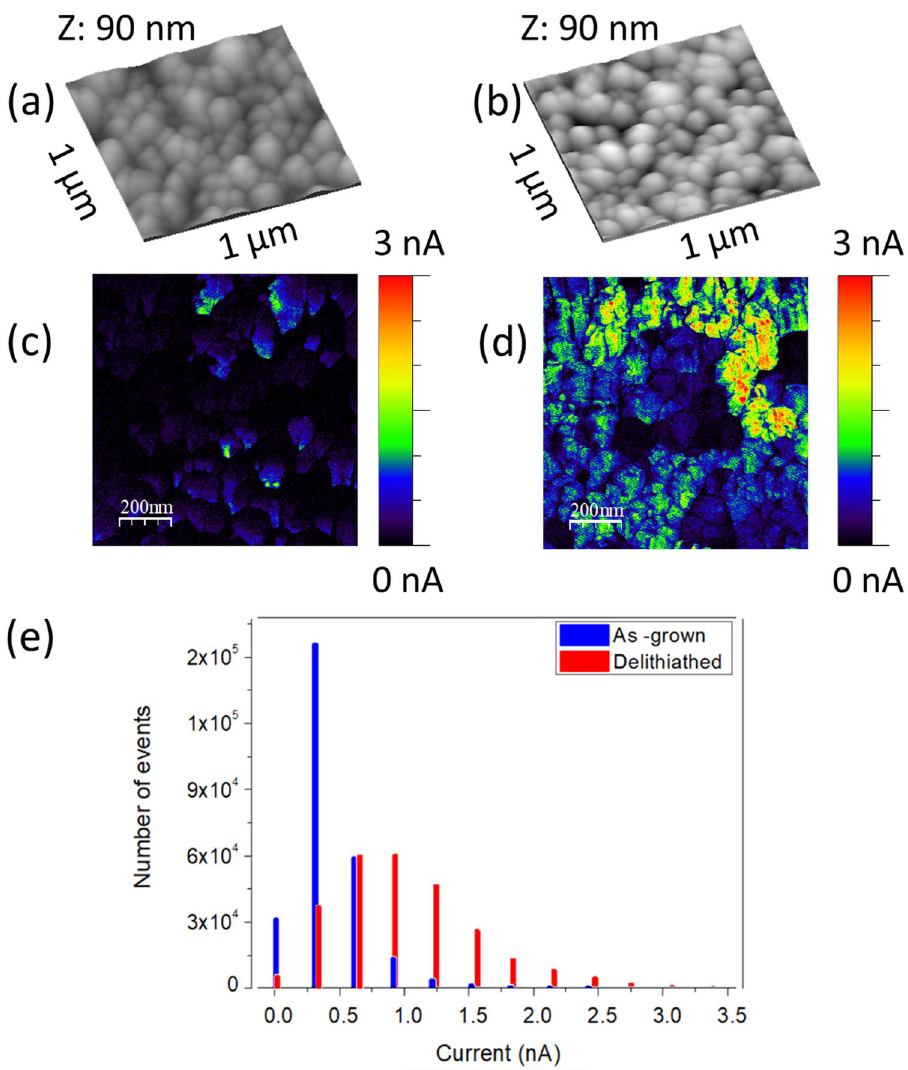
Figure 10. Topography images ( a , b ) and current maps ( c , d ) of the as-grown and delithiated samples (65 min at 10 –2 M oxalic acid), respectively. Images size 1 μm × 1 μm. ( e ) Histogram of the current maps. Both experiments are performed with the same tip and parameters: force = 150 nN and bias voltage = − 1.5 V. Figure created with WSxM 5.0 Develop (http:// www. wsxm. es) 15